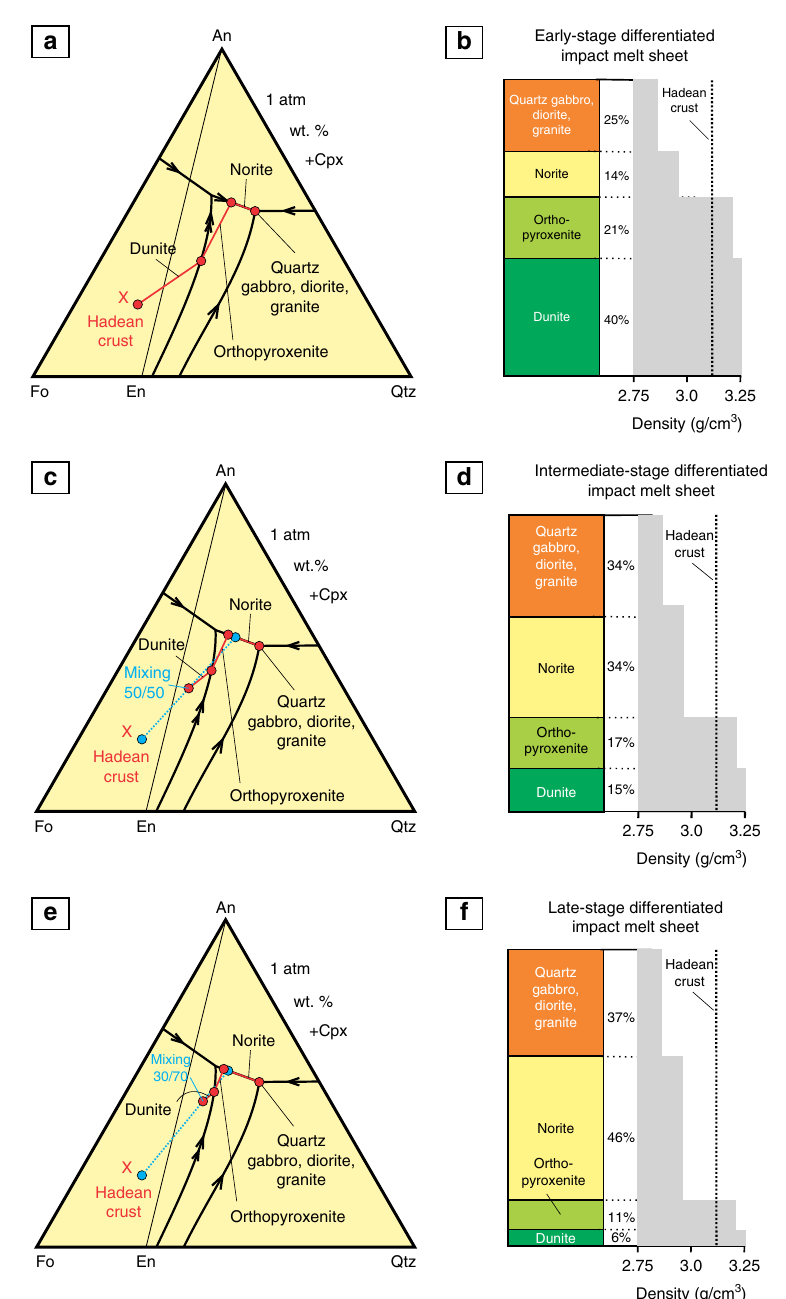
Fig. 9 Fractional crystallization sequences in a pseudoternary phase diagram Fo-An-Qtz and model cumulate stratigraphies with related density pro fi les. a , b Low-pressure fractional crystallization of the early-stage impact melt sheets having a composition of the Hadean ma fi c crust (point X). In the resulting stratigraphy, the ultrama fi c cumulates (dunite and orthopyroxenite) substantially predominate over the ma fi c-to-felsic ones (norite, quartz gabbro, diorite and granite). c , d Low pressure fractional crystallization of the intermediate-stage impact melt sheets produced by melting of the 50/50 mixture of the Hadean ma fi c crust with the bulk of ma fi c-to-felsic cumulates from the early-stage impact melt sheets. In the resulting stratigraphy, ma fi c-to-felsic cumulates start prevailing over the ultrama fi c ones. e , f Low pressure fractional crystallization of the late-stage impact melt sheets produced by melting of the 30/70 mixture of the Hadean ma fi c crust with the bulk of ma fi c-to-felsic cumulates from the intermediate-stage impact melt sheets. In the resulting stratigraphy, ma fi c-to-felsic cumulates substantially predominate over the ultrama fi c ones. Crystallization sequences at a , c and e are indicated by red lines and solid dots. Mixing end-members — the Hadean proto-crust and the bulk of ma fi c-to-felsic cumulates of impact melt sheets — are indicated by blue dots connected by dotted blue lines. Mixing proportions are arbitrarily chosen. The weight proportions of cumulates shown next to the model stratigraphies are constrained using a lever rule directly from a phase diagram. Densities of cumulate rocks are from ref. 10 . Density of the Hadean proto-crust X is calculated from its hypothetical initial composition (60 wt.% En, 20 wt.% Fo and 20 wt.% An) using data from ref. 10 . Phase diagram is simpli fi ed from ref.